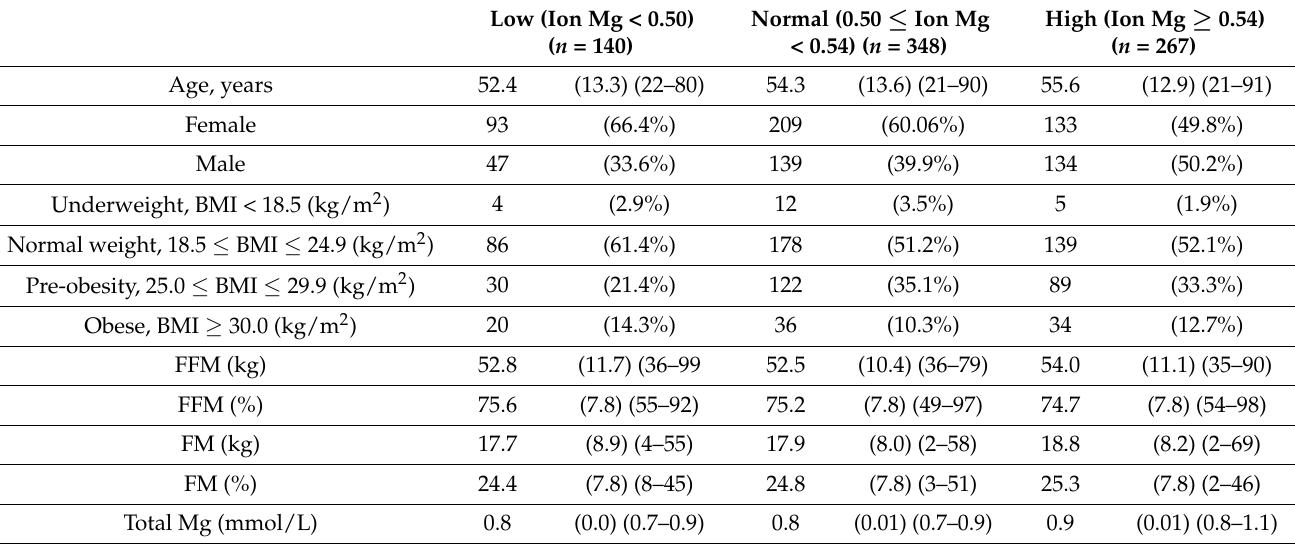
Table A6. Patients’ characteristics—Ionized Magnesium Classification